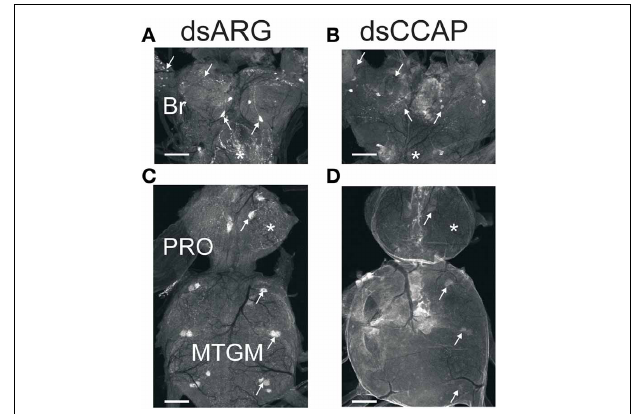
FIGURE 5 | Verification of dsRNA knockdown by immunohisto chemistry. Central nervous systems from insects injected with dsARG or dsCCAP were examined Day 5 post-injection. (A,C) Controls (dsARG) display bright CCAP-like immunoreactive staining in cell bodies and neuropile processes (arrows). Asterisks denote staining in the corpus cardiacum (A) and neuropile (C) . (B,D) dsCCAP-treated insects were devoid of staining or had reduced staining intensity. Arrows indicate location of cell bodies and neuropile processes. Asterisks denote location of the corpus cardiacum (B) and neuropile (D) . Br, Brain; PRO, prothoracic ganglion; MTGM, mesothoracic ganglionic mass. n = 30/treatment. Scale bars: 100 µ